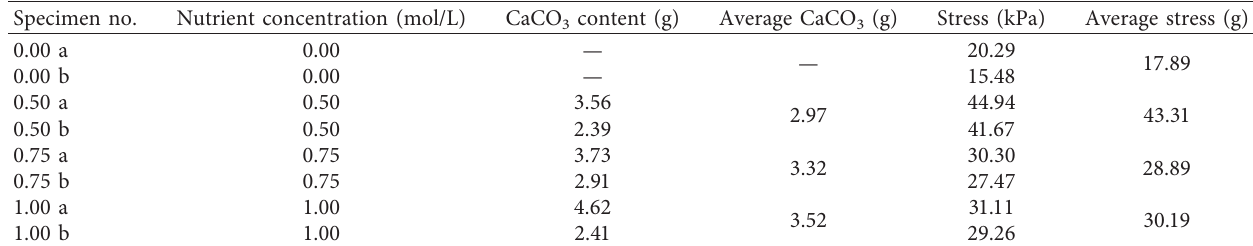
Table 6: Detail of CaCO 3 in height of soft clay specimens (curing time 28 d). Specimen